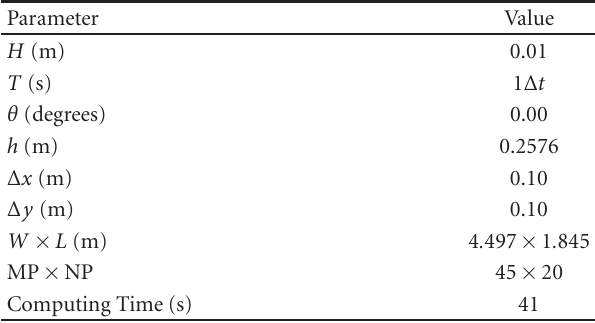
relative error of 0.75%; the technique used to approximate the error could be seen in [13].